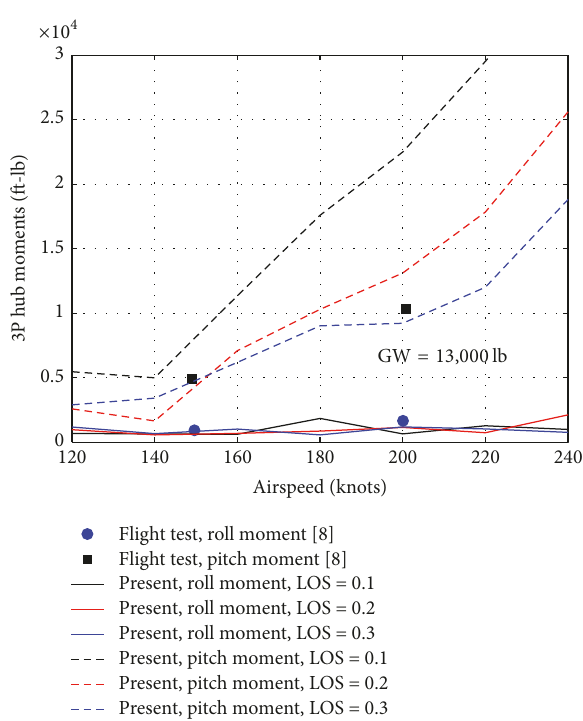
Figure 13: Validation of 3P hub moments in compound helicopter mode.